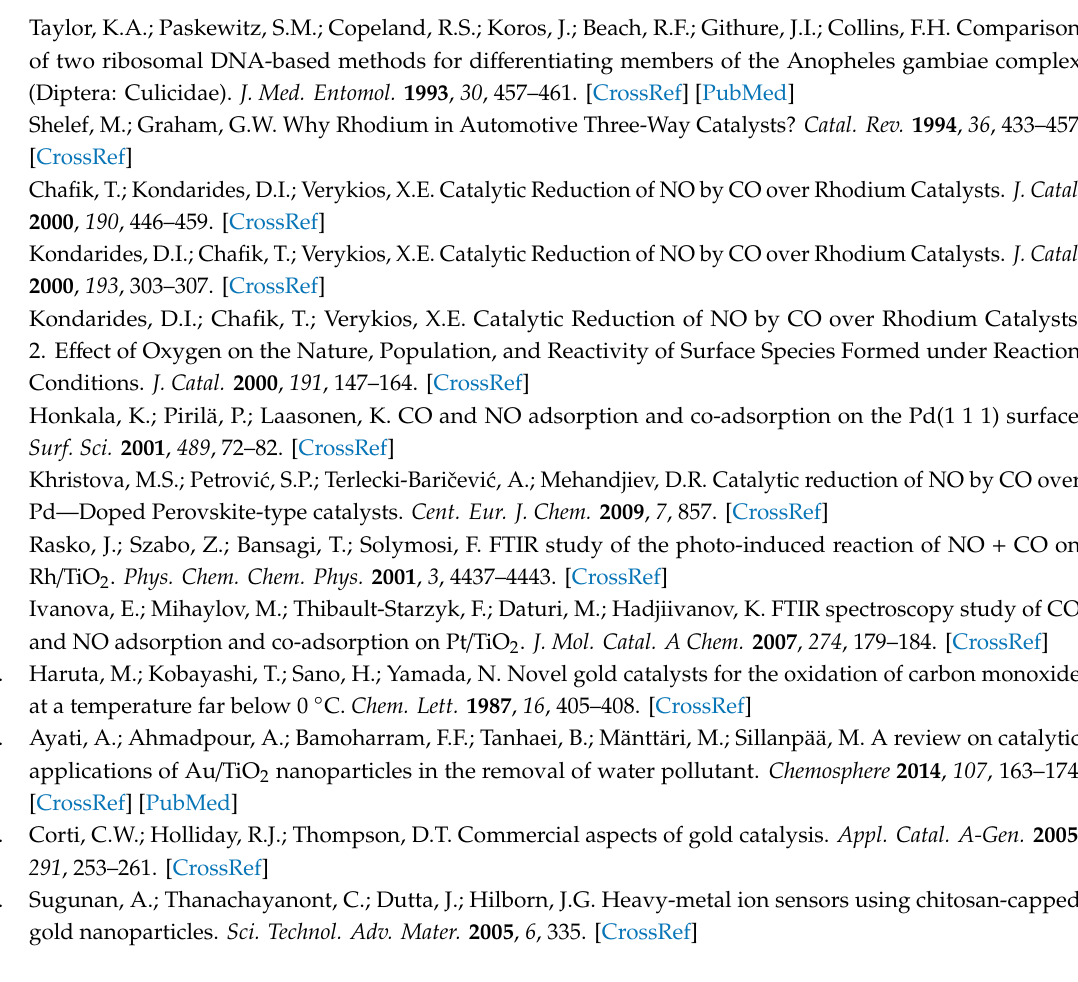
Figure S5: H 2 TPR profiles of CeO x / alumina